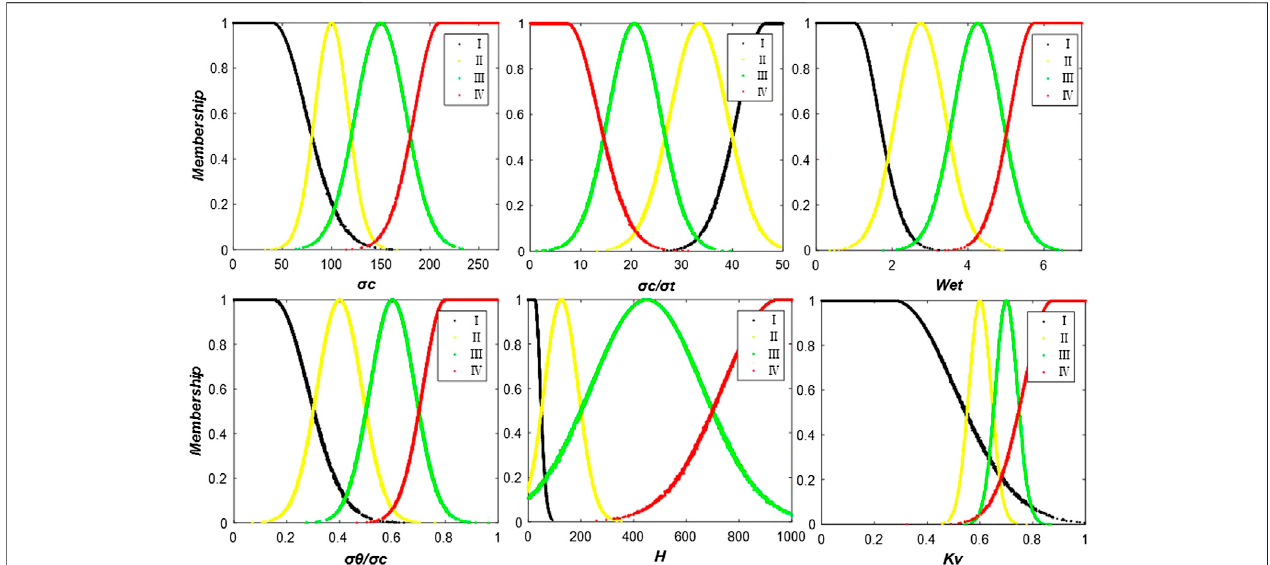
FIGURE 5 | Rock burst evaluation index cloud drop